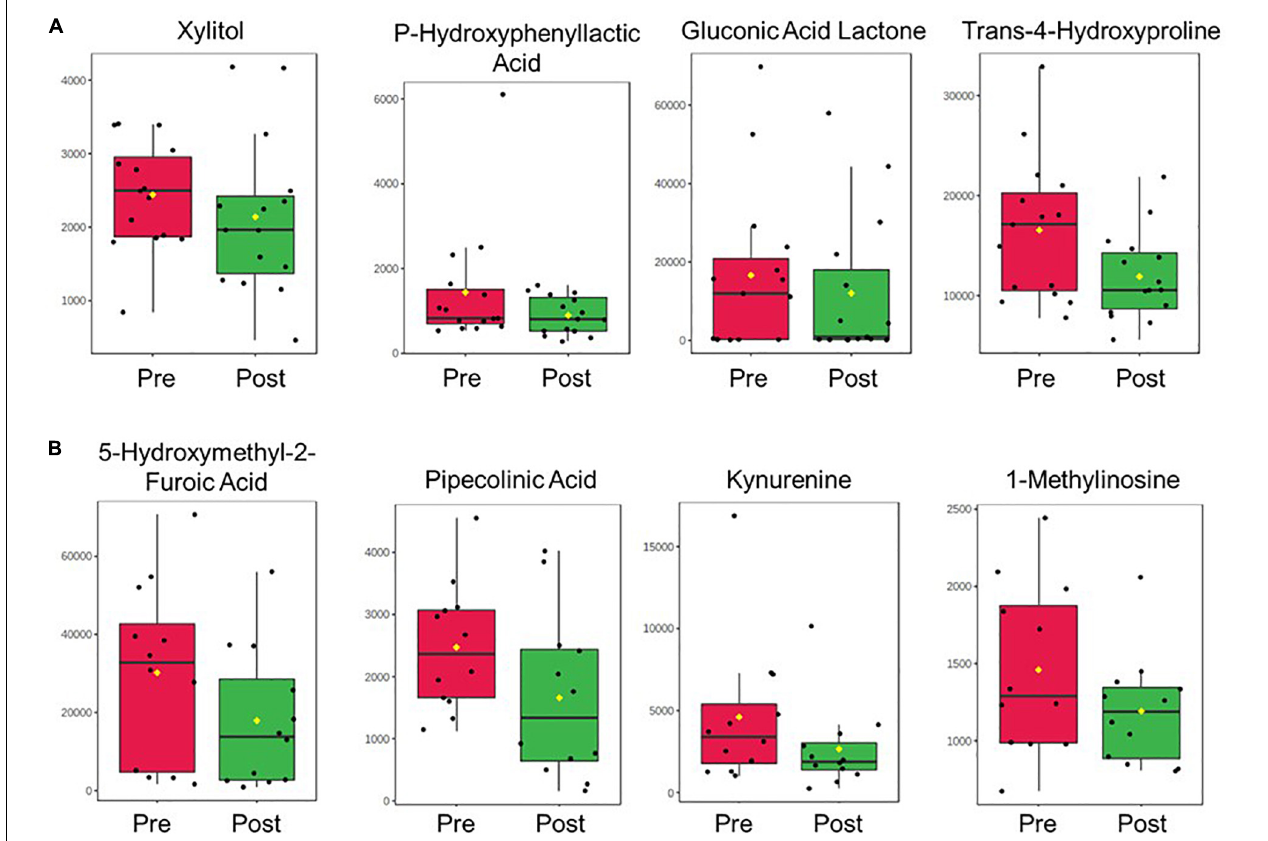
FIGURE 2 | Boxplots displaying the pre-to-post-treatment difference in abundance for the replicated metabolites in (A) plasma and (B) urine between the discovery and replication cohort studies. Metabolite abundance is displayed with arbitrary units of measurement. Yellow dots represent the group mean.